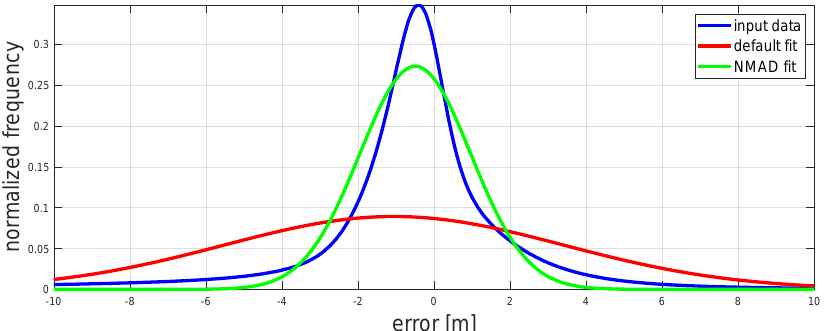
Figure 13. Example of fitting a normal distribution into non-normal distributed input data (blue). Default fit based on mean and standard deviation estimates (red) and robust fit based on median and nmAD estimates